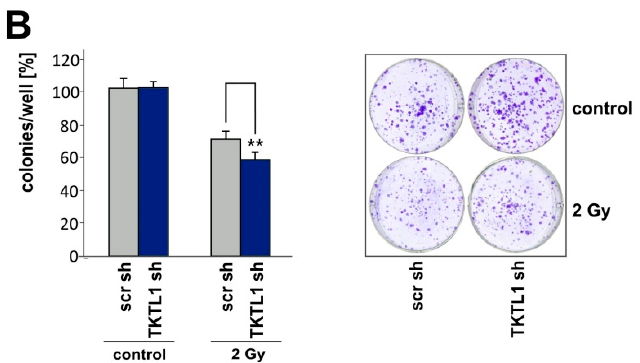
Figure 5. TKTL1 knockdown elevates ROS levels and impairs clonogenic survival subsequent to irradiation. ( A ) LNT-229-shTKTL1 and control (scr) cells were seeded in medium supplemented with 10% FCS and 25 mM glucose, 24 h later irradiated with a photon dose of 2 Gy and another 6 h later analyzed for ROS levels (median fluorescence intensity, mean + SD, ** p < 0.01); ( B ) cells were plated at very low density (500 cells in six-well plates), 24 h later irradiated and thereafter monitored for clonogenic survival (mean number of colonies, displayed as percentages of non-irradiated controls, + SD, ** p < 0.01).